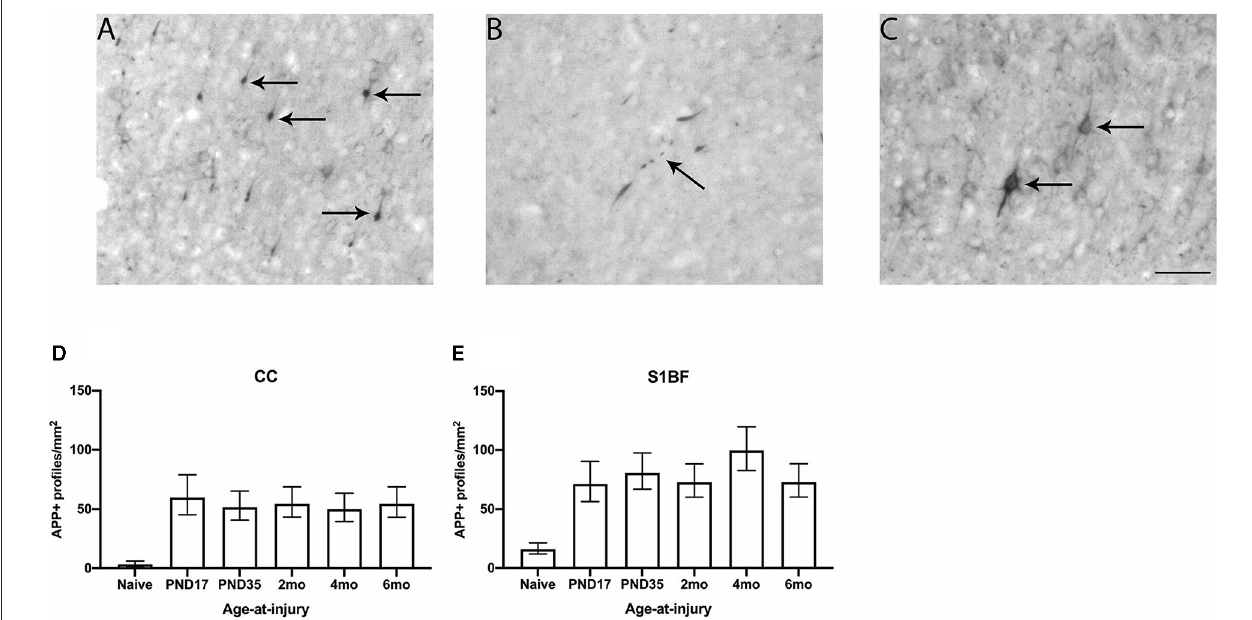
FIGURE 1 | APP neuronal profiles were quantified in the CC and S1BF. Indicative images of neuronal pathology visualized by APP immunohistochemistry were taken in the primary sensory barrel field (S1BF) of rats brain-injured at 6-months of age. Quantitative analysis included bulbs (A) , blebbing (B) , and cell bodies (C) indicated by the black arrows (scale bar = 50 µ m). Counts of neuronal pathology are expressed as the number of APP-positive (APP + ) profiles/mm 2 (mean ± 95%CI) in the corpus callosum (CC) and S1BF. Significantly more APP + profiles were observed following mFPI, regardless of age-at-injury, compared to naïves in both the CC (D) and the S1BF (E)